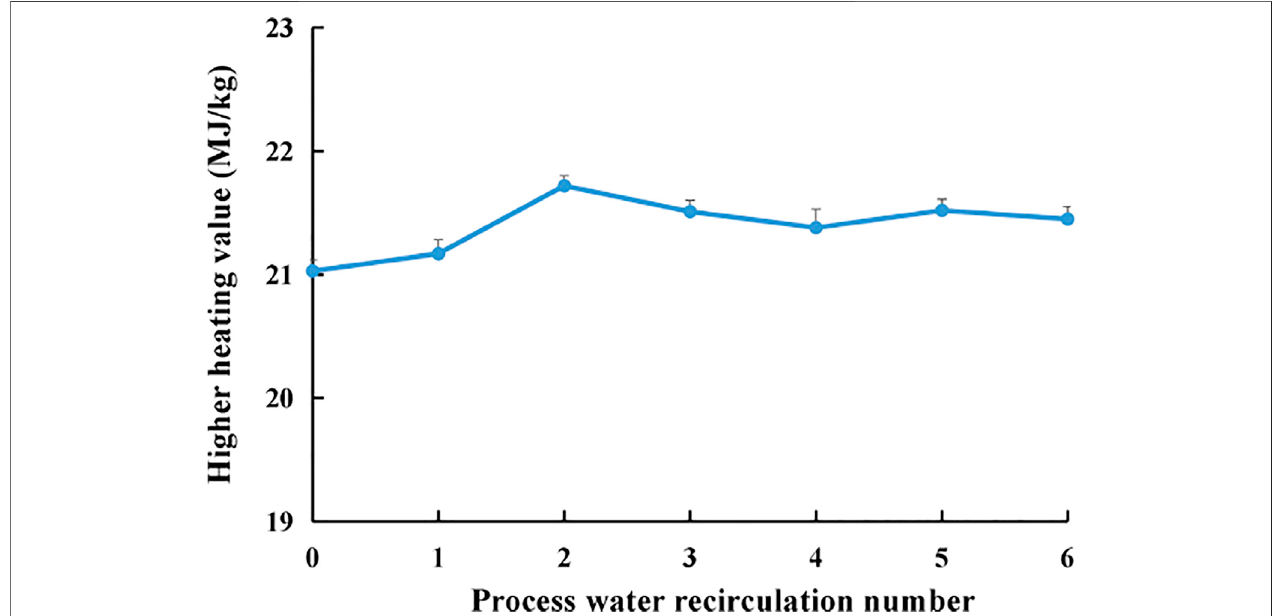
Frontiers in Energy Research |